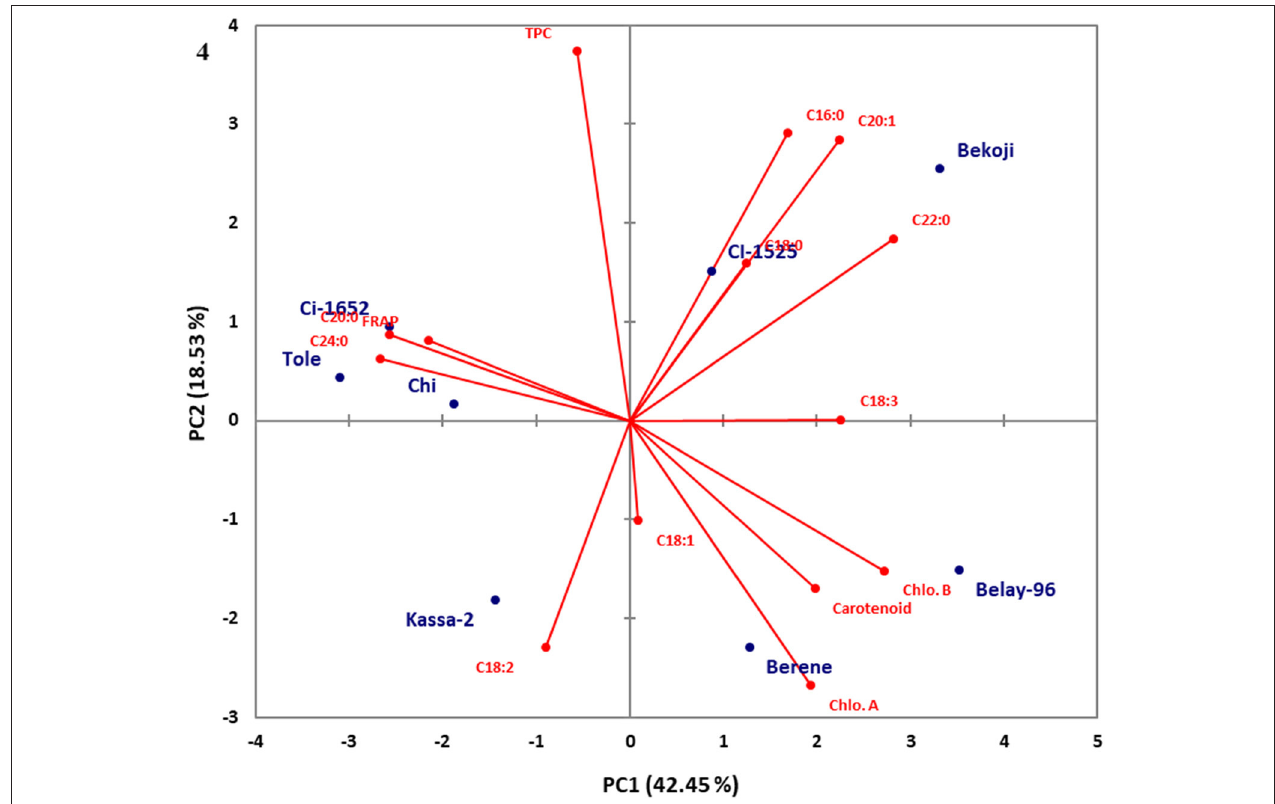
FIGURE 4 | Score plot of principal component analysis (PCA) for the combined data sets of fatty acid composition, total phenolic, carotenoid, and chlorophyll contents and their antioxidant properties for the linseed